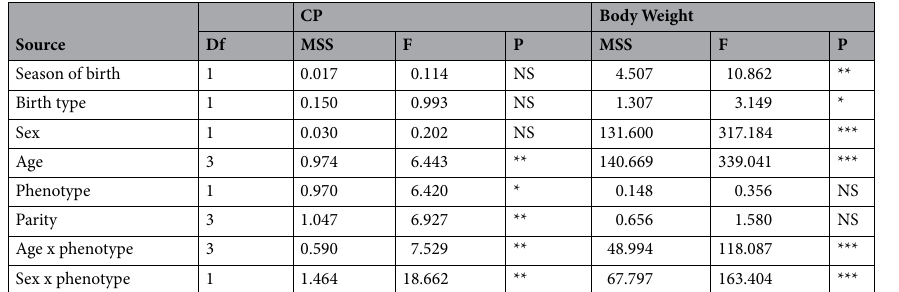
Table 8. ANOVA of HSP70 showing the effect of genetic and non-genetic factors on crossing point (CP) values and body weight in Jamunapari goats. Df Degree of freedom; MSS Mean Sum of squares; F F-value; P *** P < 0.001, ** P < 0.01, * P < 0.05; NS Non-significant; CP Crossing point; Season of birth, February–March and October–November. Birth type: Single & Multiple; Age, 3, 9, 12 months and adults age of animals; Phenotype– Heat stress-tolerant (HST) and Heat stress-susceptible (HSS); Parity, Parity of dam; Age x phenotype, Interaction between age and phenotype; Sex x phenotype, Interaction between sex and phenotype.